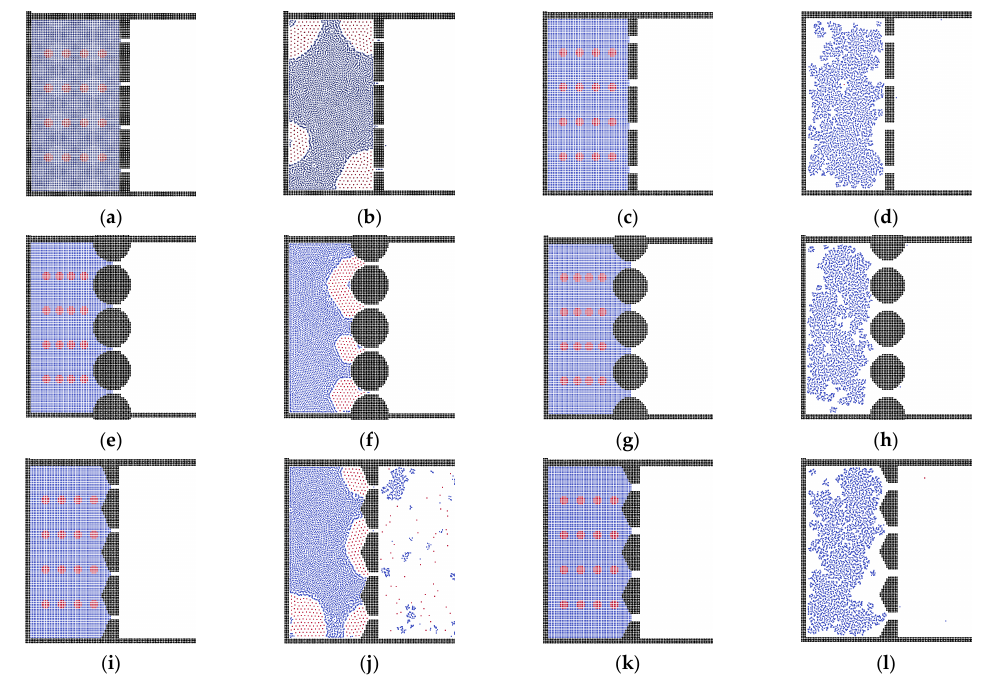
Figure 4. The separation processes in the triangular membrane during different time steps. ( a ) Step = 0, ( b ) Step = 20, ( c ) Step = 100, ( d ) Step = 200. To investigate the effect of channel width, as shown in Figure 5, we set models with different channel sizes. In the flat membrane system, the smaller channels hold more oil particles in the box, while in the membrane with a wider channel, the entire oil phase is pushed out. This is the same in the sphere and triangular membrane systems. However, in the small-size channel system, the sphere and triangular membranes block the oil phase, because the small pore size results in a stronger interaction between fluid particles and pores.